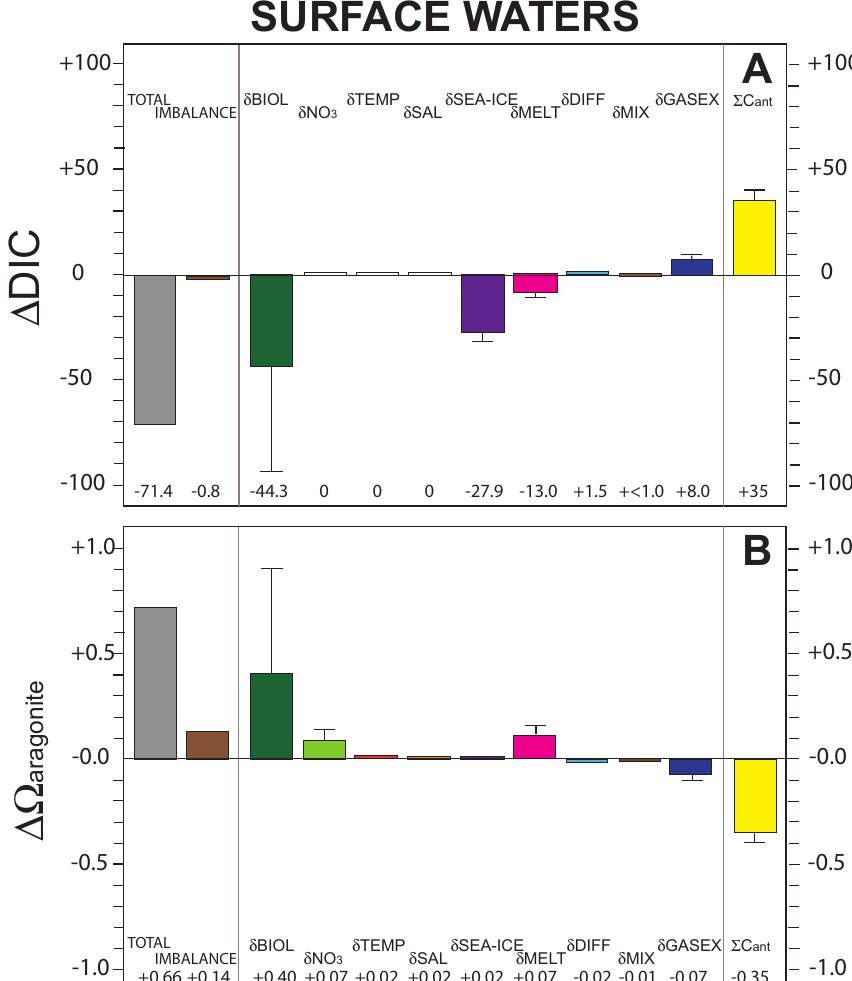
Fig. 11. Winter/early-spring to summertime changes in surface water DIC ( 1 DIC SURFACE ; grey) and (cid:127) ( 1(cid:127) SURFACE ; grey) using mean winter/early-spring to summertime changes in seawater CO 2 -carbonate chemistry values reported in Table 3. The imbalance in both terms is shown in brown. (A) This panel shows the mean impact on DIC as described in Eq. (3) of δ DIC BIOL (green), δ DIC NO (light green), 3 δ DIC TEMP (red), δ DIC SALINITY (orange), δ DIC SEAICE (purple), δ DIC MELT (pink), δ DIC GASEX (blue), δ DIC VERTDIFF (cyan), and δ DIC VERTMIXING (dark brown). The δ DIC ADVECTION cannot be determined and likely contributes to the imbalance. (B) This panel shows the mean impact on (cid:127) as described in Eq. (4) of δ(cid:127) BIOL , δ(cid:127) NO , δ(cid:127) TEMP , δ(cid:127) SALINITY , δ(cid:127) SEAICE , (cid:127) MELT , δ(cid:127) VERTDIFF , 3 δ(cid:127) VERTMIXING , δ(cid:127) GASEX , and δ(cid:127) ADVECTION . The long-term change in DIC and (cid:127) due to anthropogenic CO 2 uptake is also shown for reference to the short-term, seasonal changes ( 6(cid:127) CANT ,